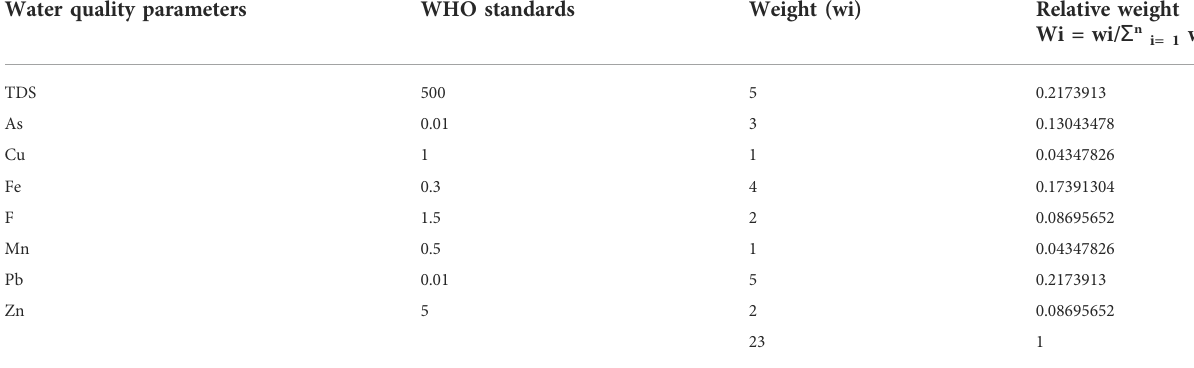
TABLE 6 Water Quality Index based on heavy metal concentration in groundwater of the “ twin cities. ” Water quality parameters